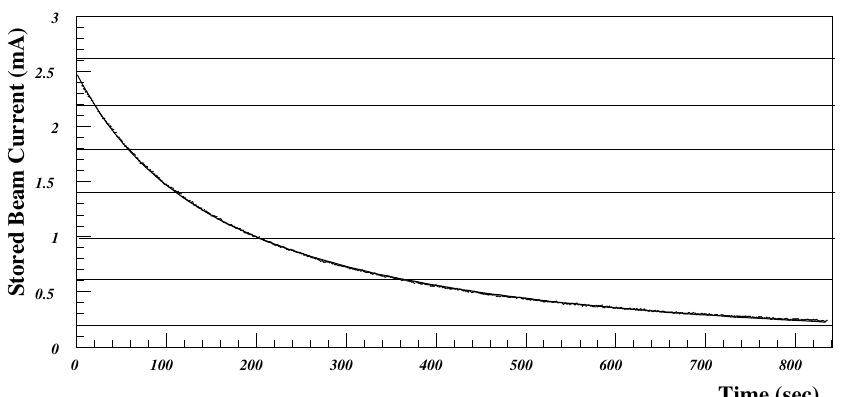
FIG. 5. Electron beam current versus time for one fill. The horizontal lines show the current intervals used to classify scalar